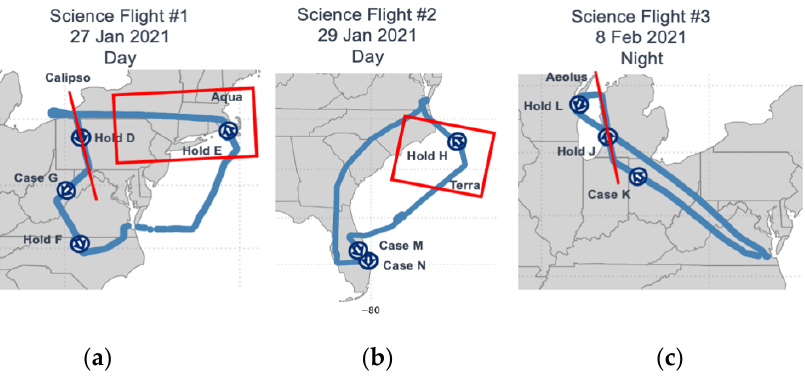
Figure 5. Depictions of the flight paths and analysis regions for ( a ) Science Flight #1, ( b ) Science Flight #2, and ( c ) Science Flight #3. The red boxes and lines denote EOS satellite overpasses within approximately 15 min of the CMIS aircraft flight.